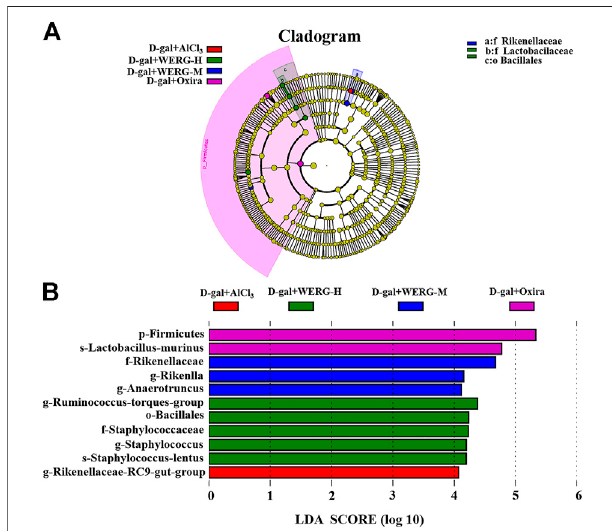
FIGURE 6 | Gut microbiota differences. Cladograms reveal microbial phylogenetic branches associated with treatment groups status in the AD mousemodel (A) ;lineardiscriminantanalysis(LDA) (B) .Statisticalsigni fi cance re fl ects both p < 0.05 for Student ’ s t test and LDA score threshold > 4 was listed, n = 5 mice per